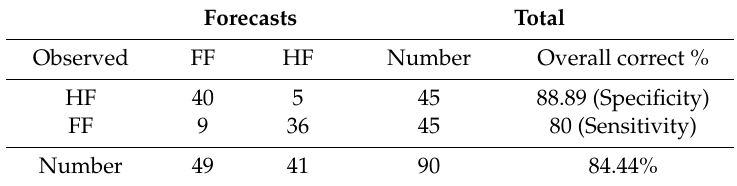
Table 7. Classification of failing firms (FF) and healthy firms (HF) two years earlier.